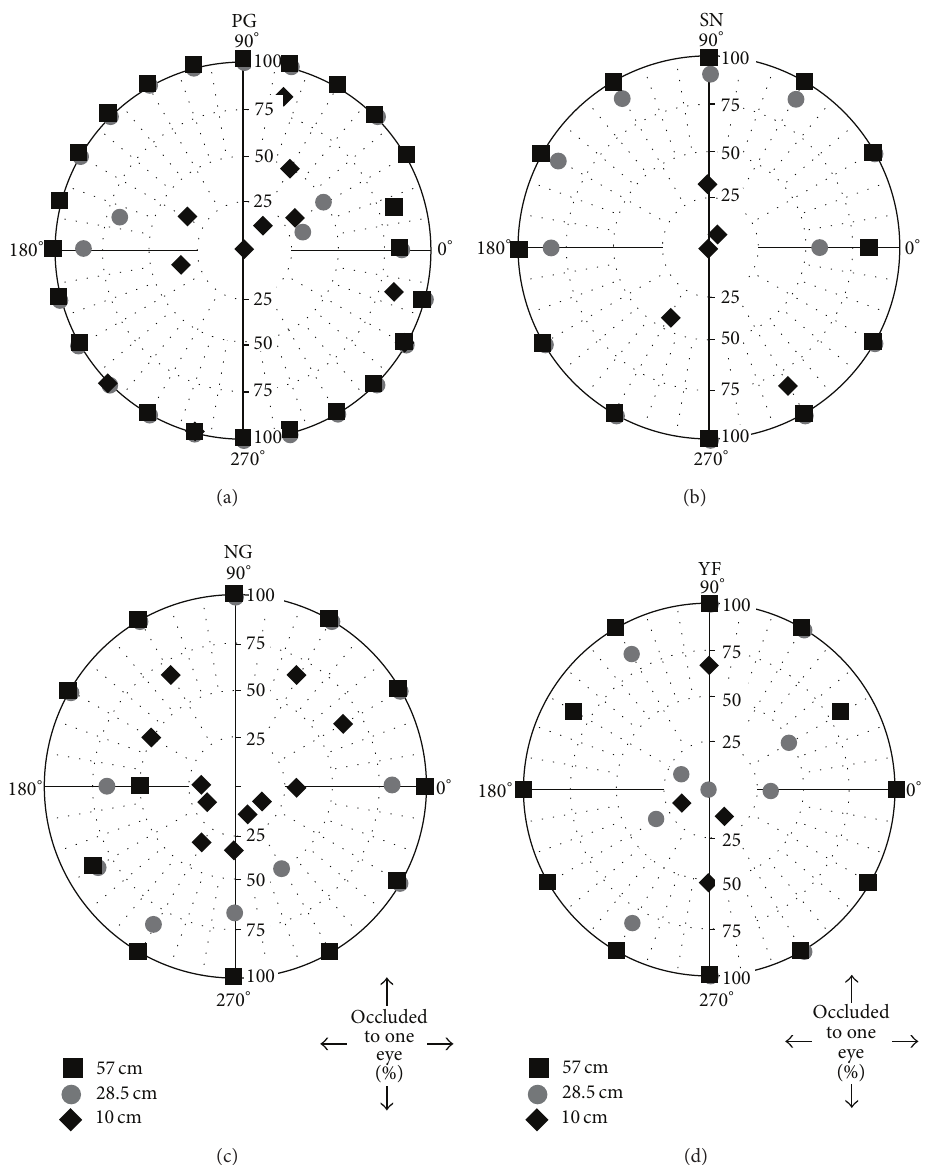
Figure 11: Individual polar plots indicating the percentage of trials; the fixation stimulus became occluded to one eye. Percentage is plotted along vertical radii; radius angles are plotted on the